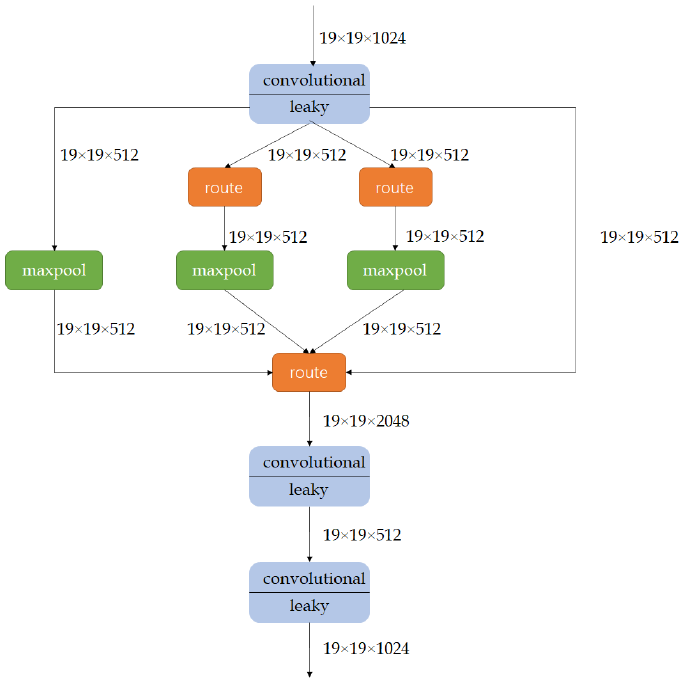
Figure 3. Spatial Pyramid Pooling Module.